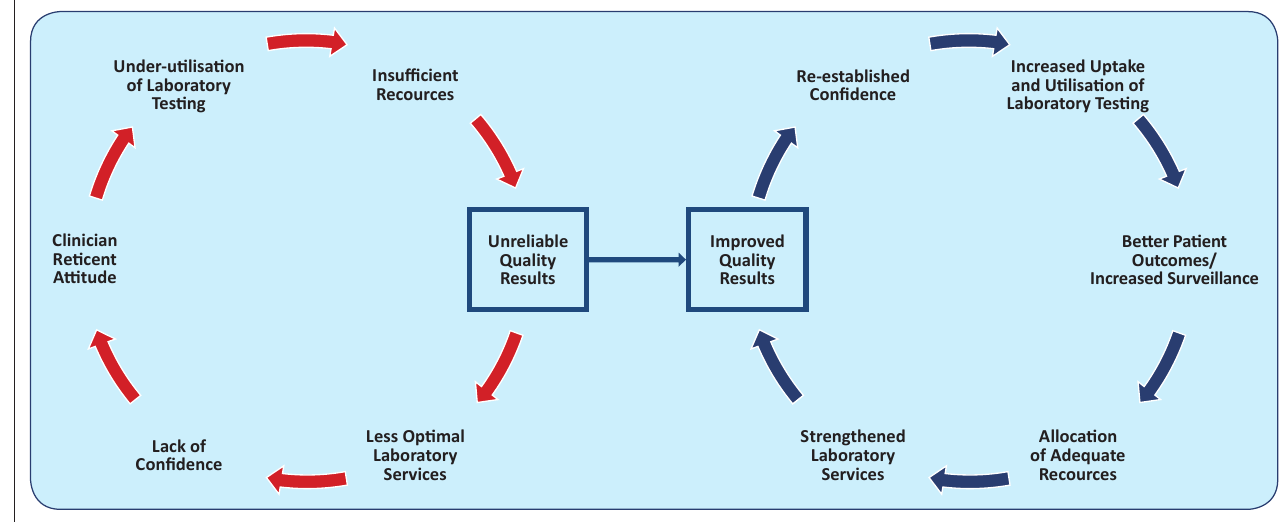
FIGURE 1 : Quality matters: A catalyst to a tipping point for strengthening laboratory